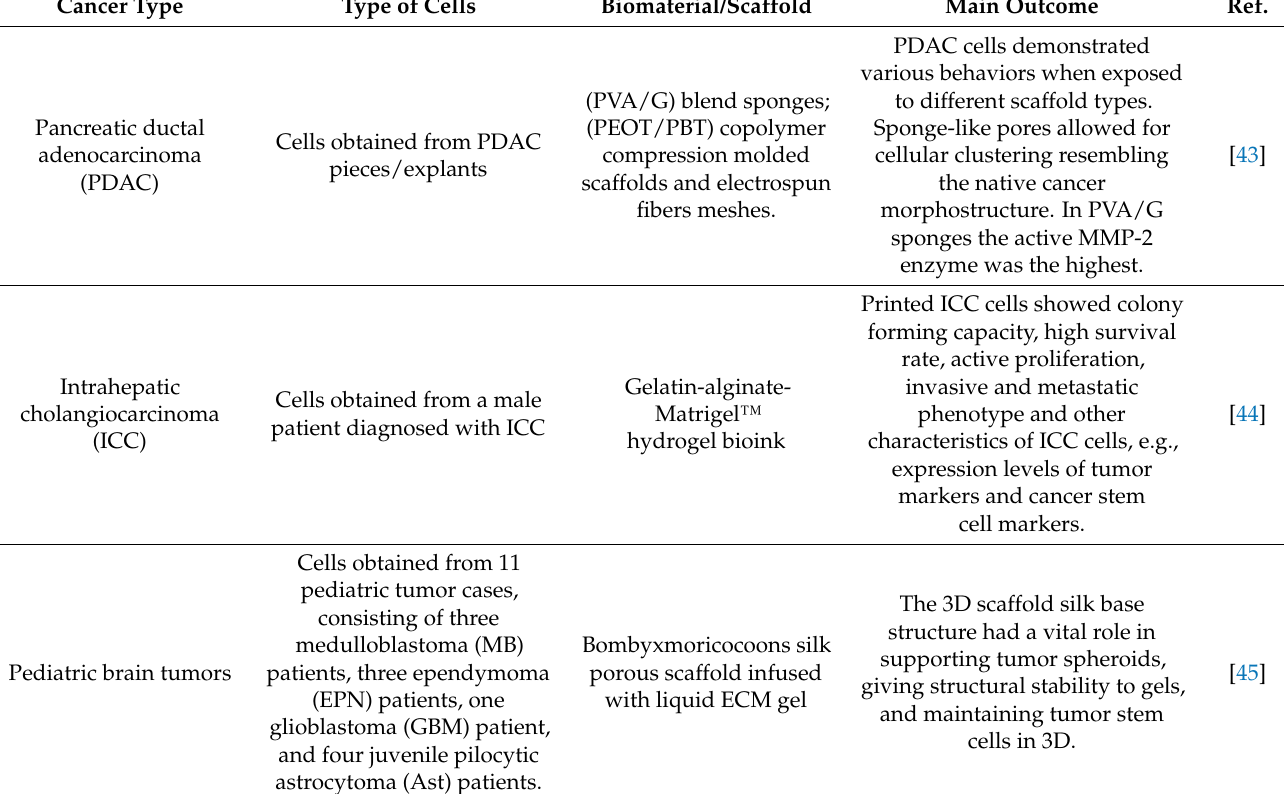
Table 2. 3D in vitro models that utilize patient-derived cells and